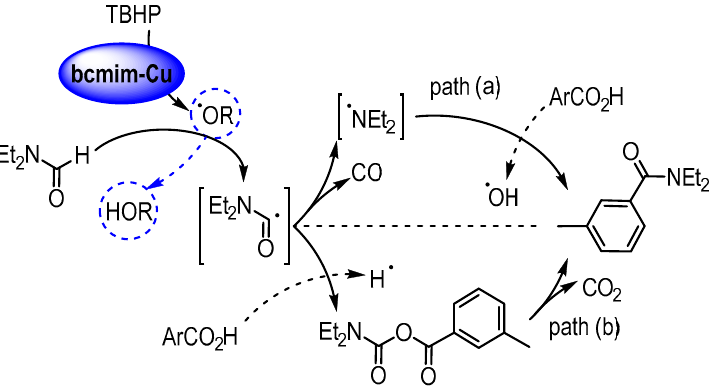
Figure 1. ( a ) E-factor profile; ( b ) radial-pentagon diagram with metrics (%): reaction yield, atom economy (AE), reaction mass efficiency (RME), materials recovery parameter (MRP), inverse of stoi- chiometric factor